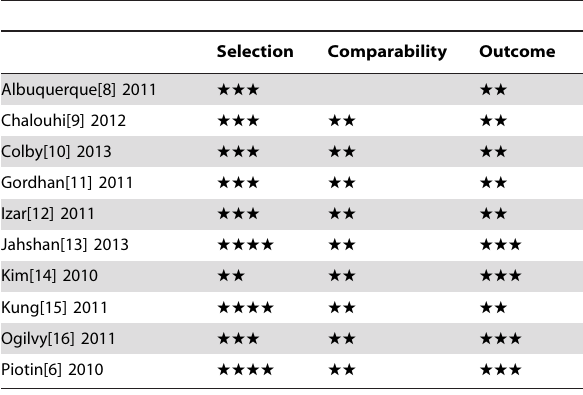
Table 2. Risk of bias in the observational studies using Ottawa-Newcastle